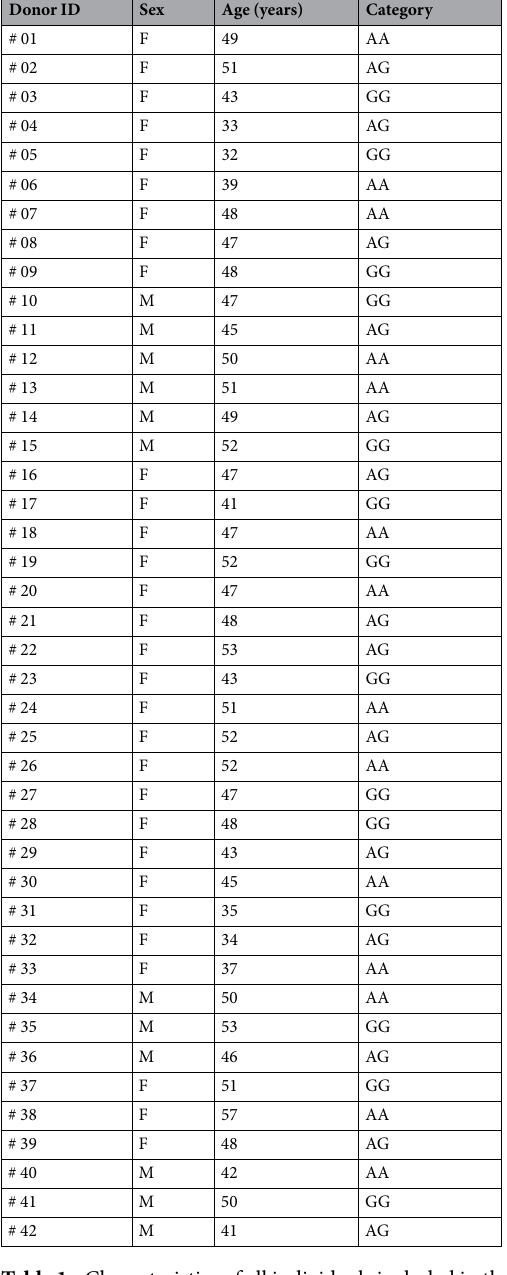
Table 1. Characteristics of all individuals included in the